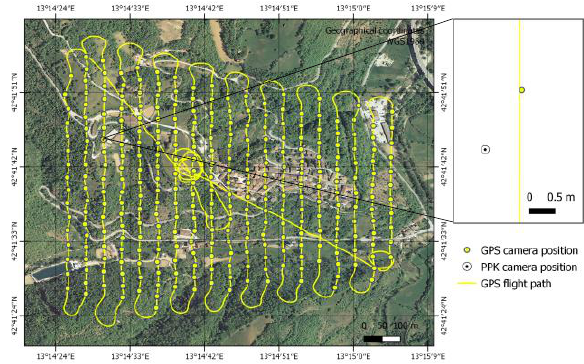
Figure 5. eBee RTK flight path and camera positions. In the detail, comparison among raw and PPK camera position.